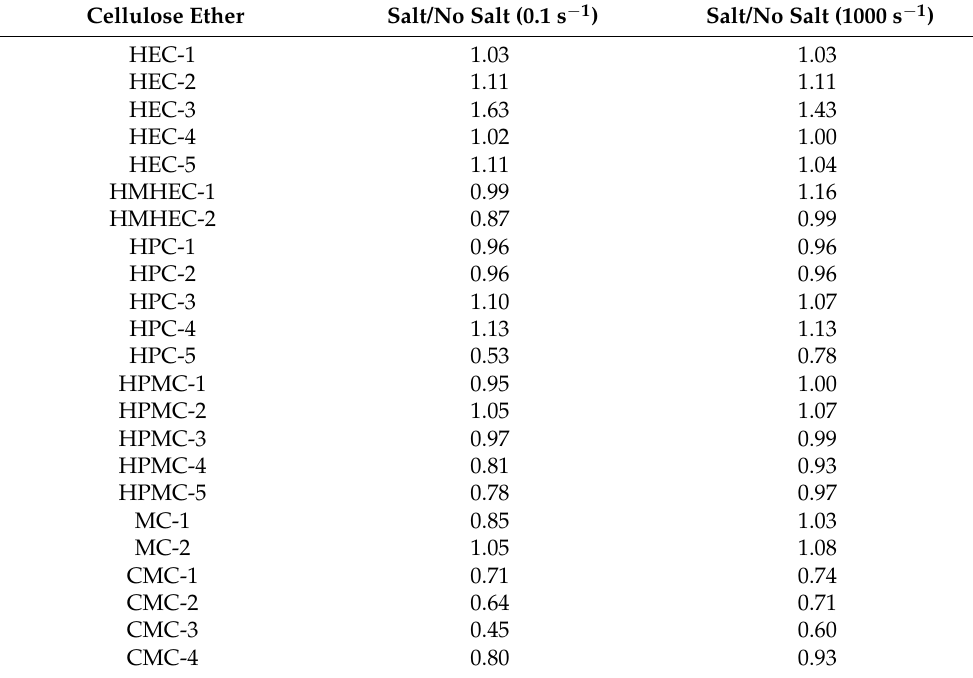
Table 2. Ratio of the polymer solution containing salt (NaCl) to the polymer solution without salt at two shear rates for the tested cellulose